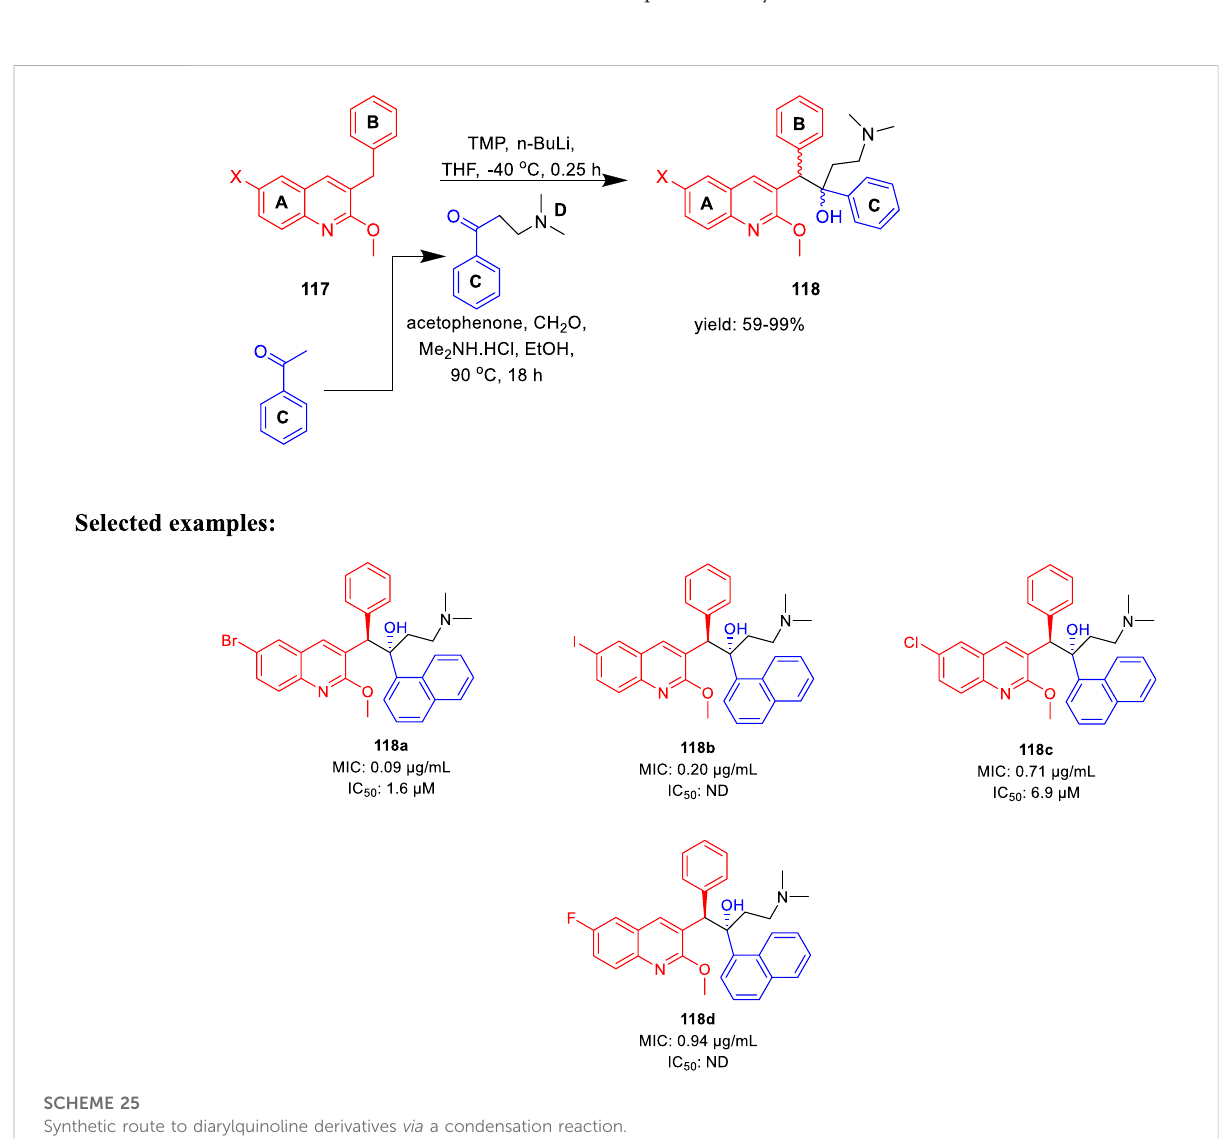
FIGURE 9 SAR study of